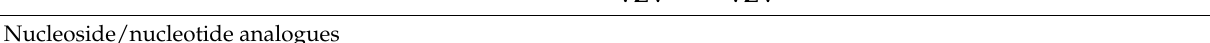
Table 3. Candidate anti-VZV drugs. Compounds described in the last years showing promising activity against VZV. Compound